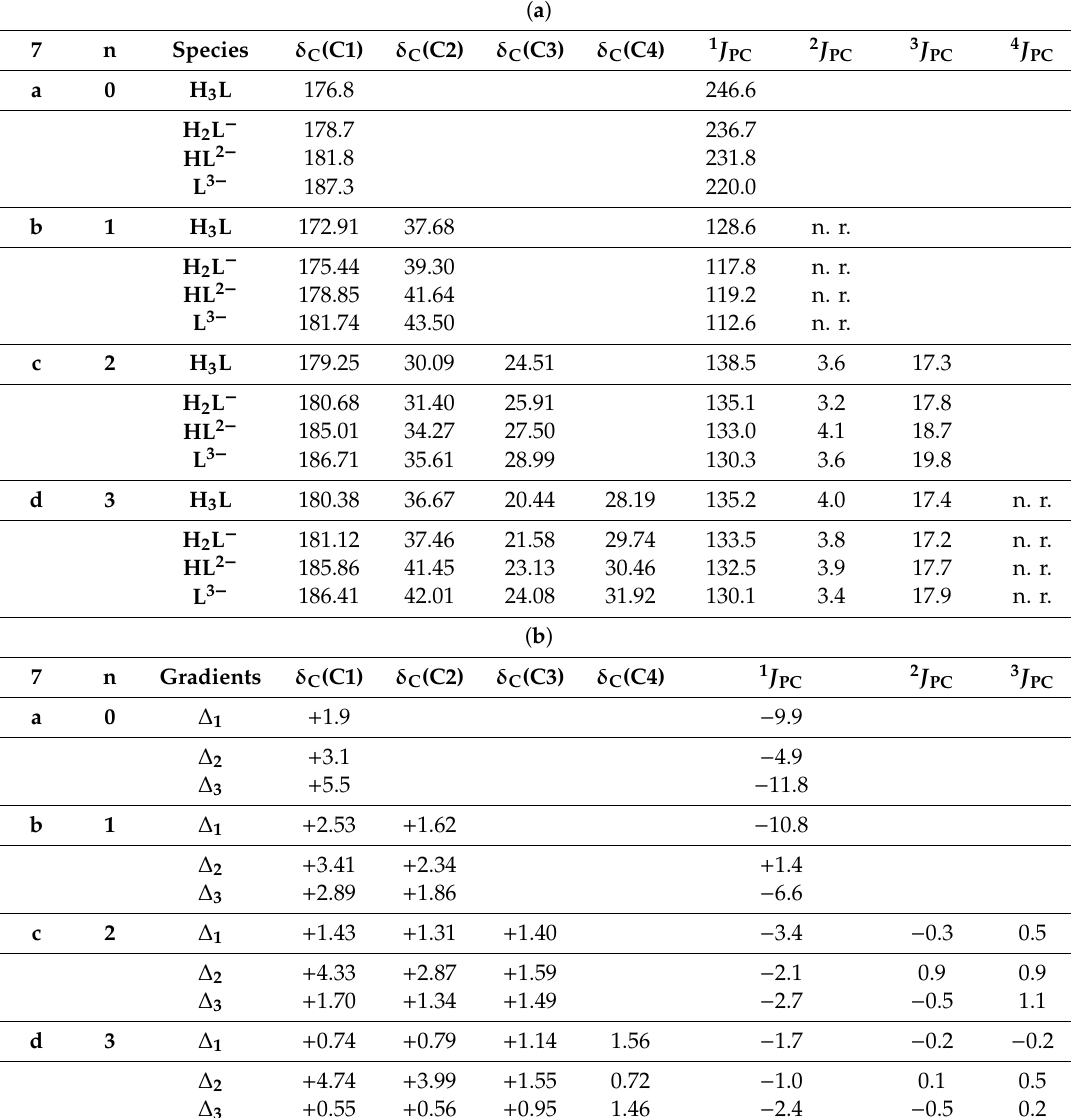
Figure 3c. The deprotonation sequence reported in [4] corresponds to: HOOC-CH 2 -CH 2 -PO 3 H 2 → − → − − → − − HOOC-CH 2 -CH 2 -PO 3 H OOC-CH 2 -CH 2 -PO 3 H OOC-CH 2 -CH 2 -PO 32 . Deprotonation at − PO 3 H 2 or PO 3 H is a ffi liated with high field shifts of δ P , while deprotonation at HOOC induces a low field shift for δ P